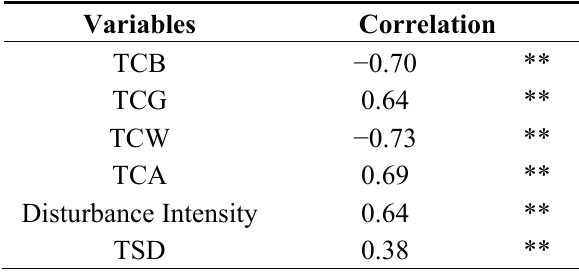
Table 3. Correlations between independent variables and MCH.